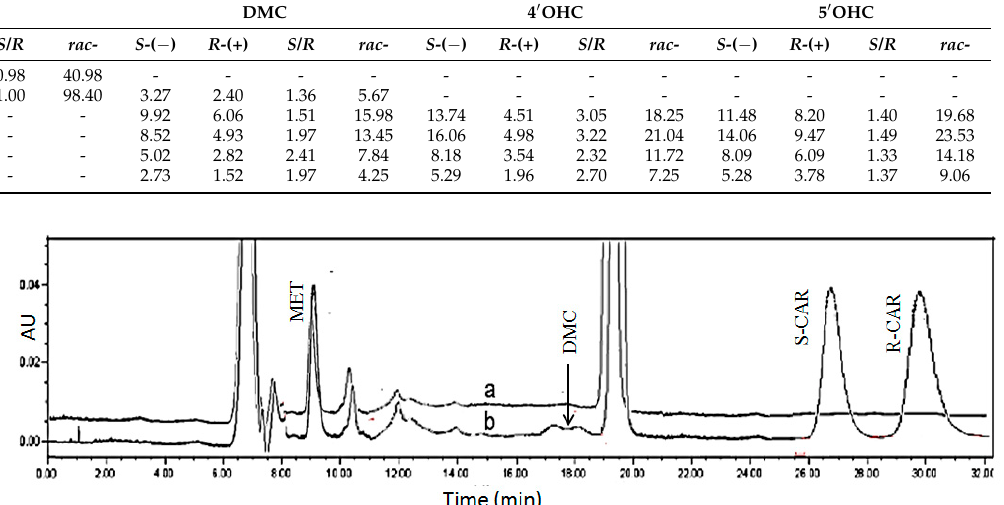
Figure 8. Chromatograms corresponding to (a) a blank plasma sample of patient #2 (spiked with 2.5 µ L of 100 ng/mL MET (IS) stock), (b) a plasma sample of patient #2 (sample obtained 1 h following a single oral dose of rac -CAR (25 mg)).